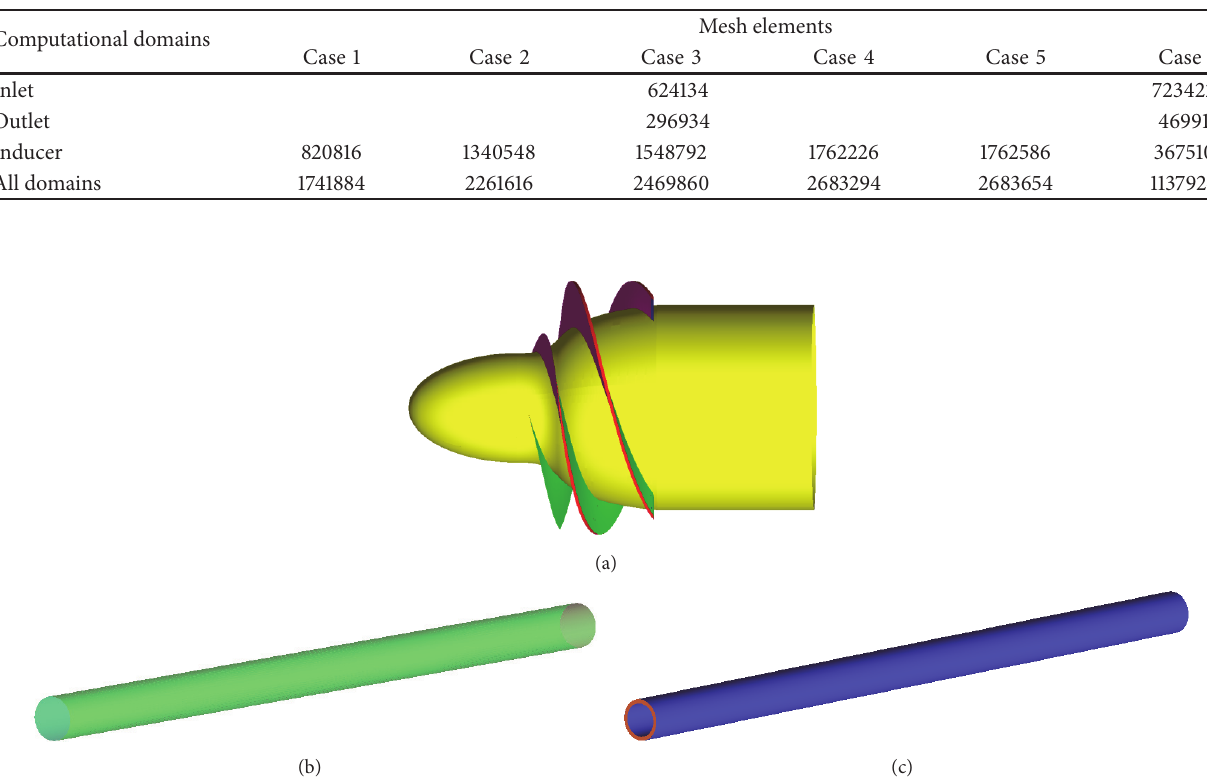
Figure 1: (a) A 3D view of the inducer; (b) the extended inlet duct; (c) the outlet